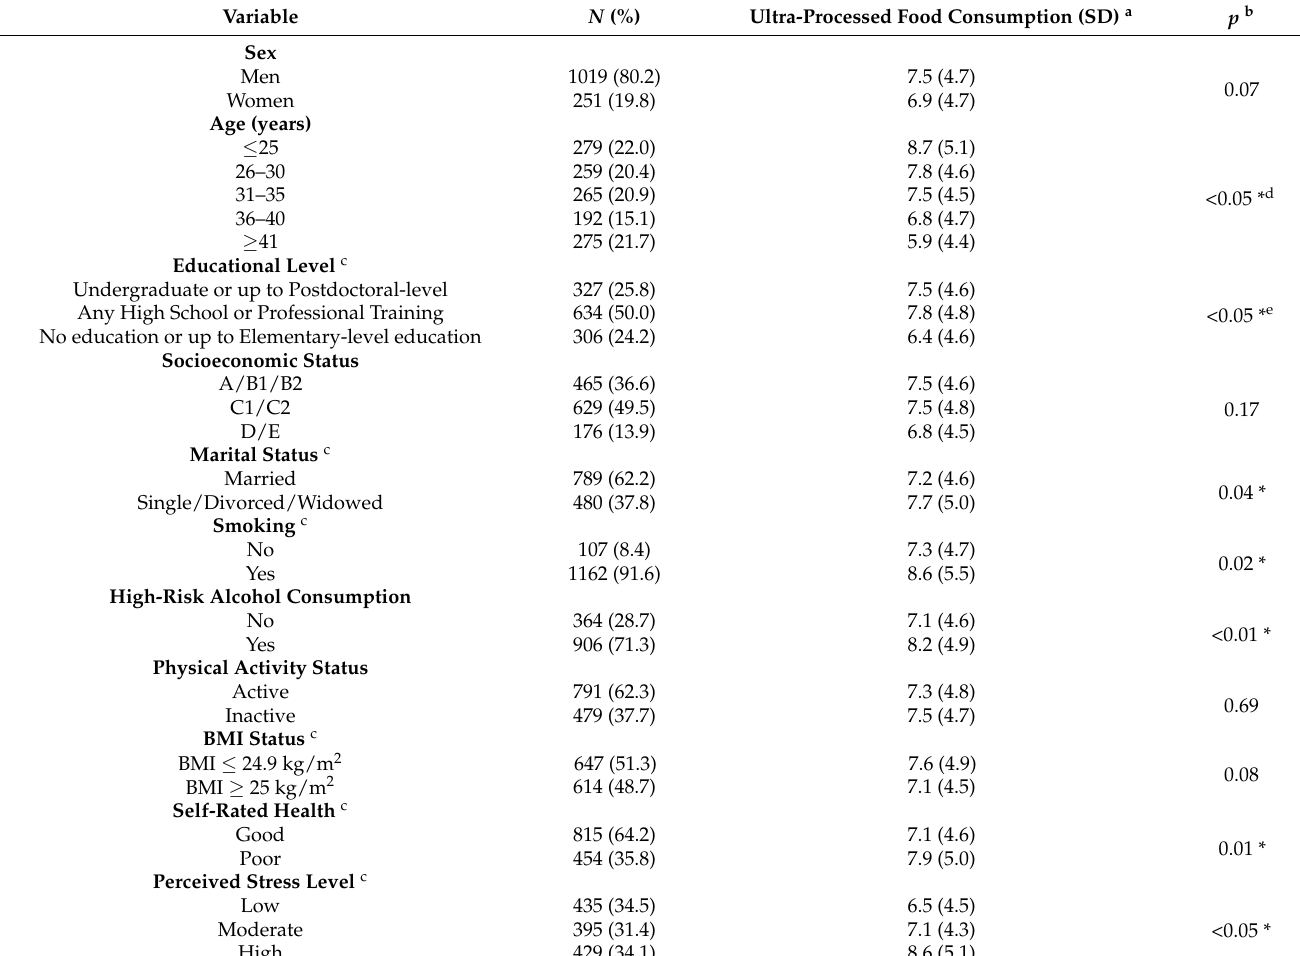
Table 1. The distribution of ultra-processed food consumption by demographic, socioeconomic, and behavioral variables; health indicators; and perceived stress